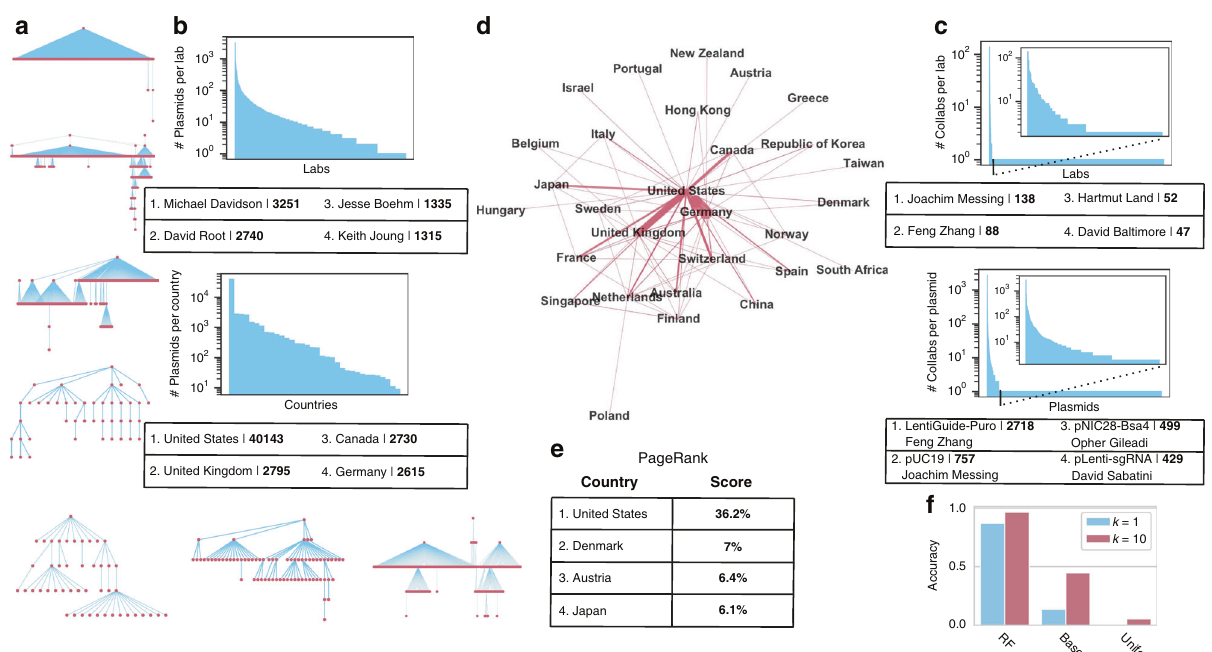
Fig. 4 Lineage networks reveal skewed distributions in Addgene deposits and facilitate ancestor lab attribution with simple machine-learning models. a Example ancestry-descendent lineages inferred from Addgene plasmid data. The largest lineage top, followed next down by the largest diameter, followed by a collection of examples from the more complex lineages. b Number of deposits. Above, the number of plasmids deposited per lab, with ranked labs (descending) on the x axis and log10 of the number of plasmids deposited on the y axis. Top contributing labs in the table. Below, the number of deposits per country. c Number of ancestry-descendent connections. Above, number of ancestry-descendent linkages per lab, with most linked shown in the table as in ( b ). Below, a number of linkages per plasmid. For each, subpanel shows the left side of the distribution by cutting out single linkages which constitute the right tail. d Lineage network between nations. Links indicate that at least one lab in a country has a plasmid derived from the other country or vice versa. Width of the link is proportional to the number of connected labs. e Top four PageRank scores from the lineage network from ( d ), represented as a directed weighted graph. The score is shown here as a percentage. f Top-k accuracy predicting the ancestor lab: of a simple Random Forest (RF) model, the baseline of predicting the most abundant class(es) from the training set, and guessing uniformly